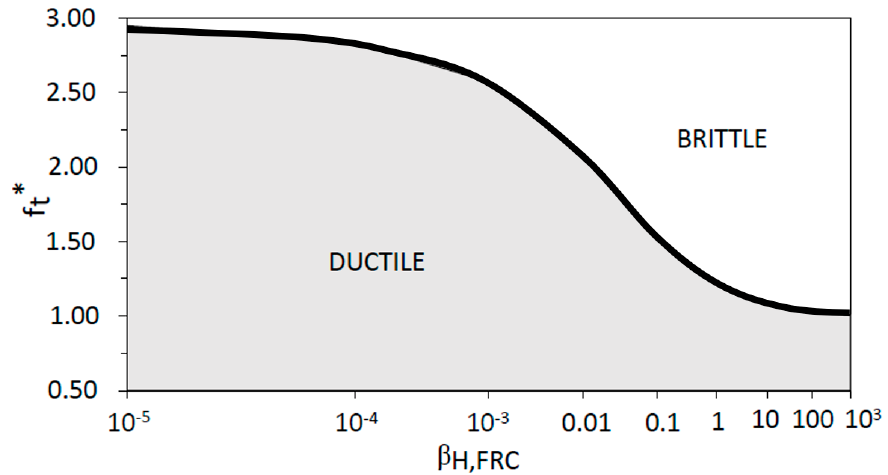
Figure 14. Transition between ductile and brittle behavior.